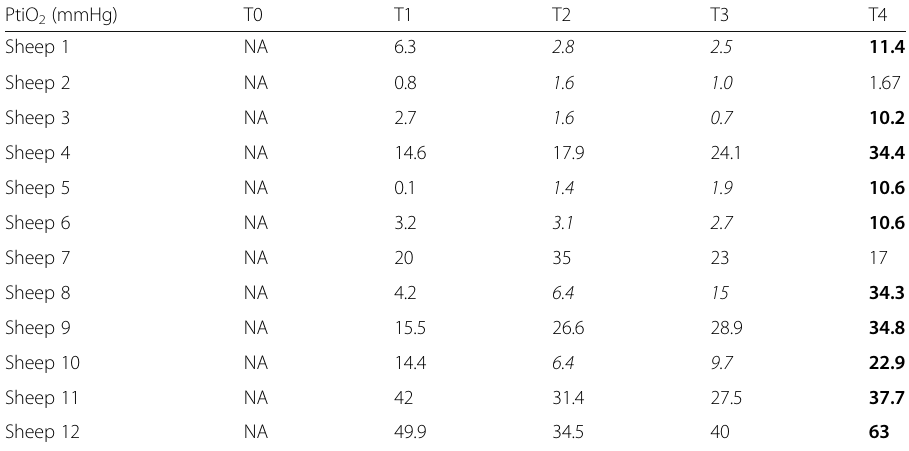
Table 5 Partial pressure of tissue oxygenation (PtiO 2 ) expressed in mmHg for all subjects over time PtiO 2 (mmHg) T0 T1 T2 T3 T4 Sheep 1 NA NA